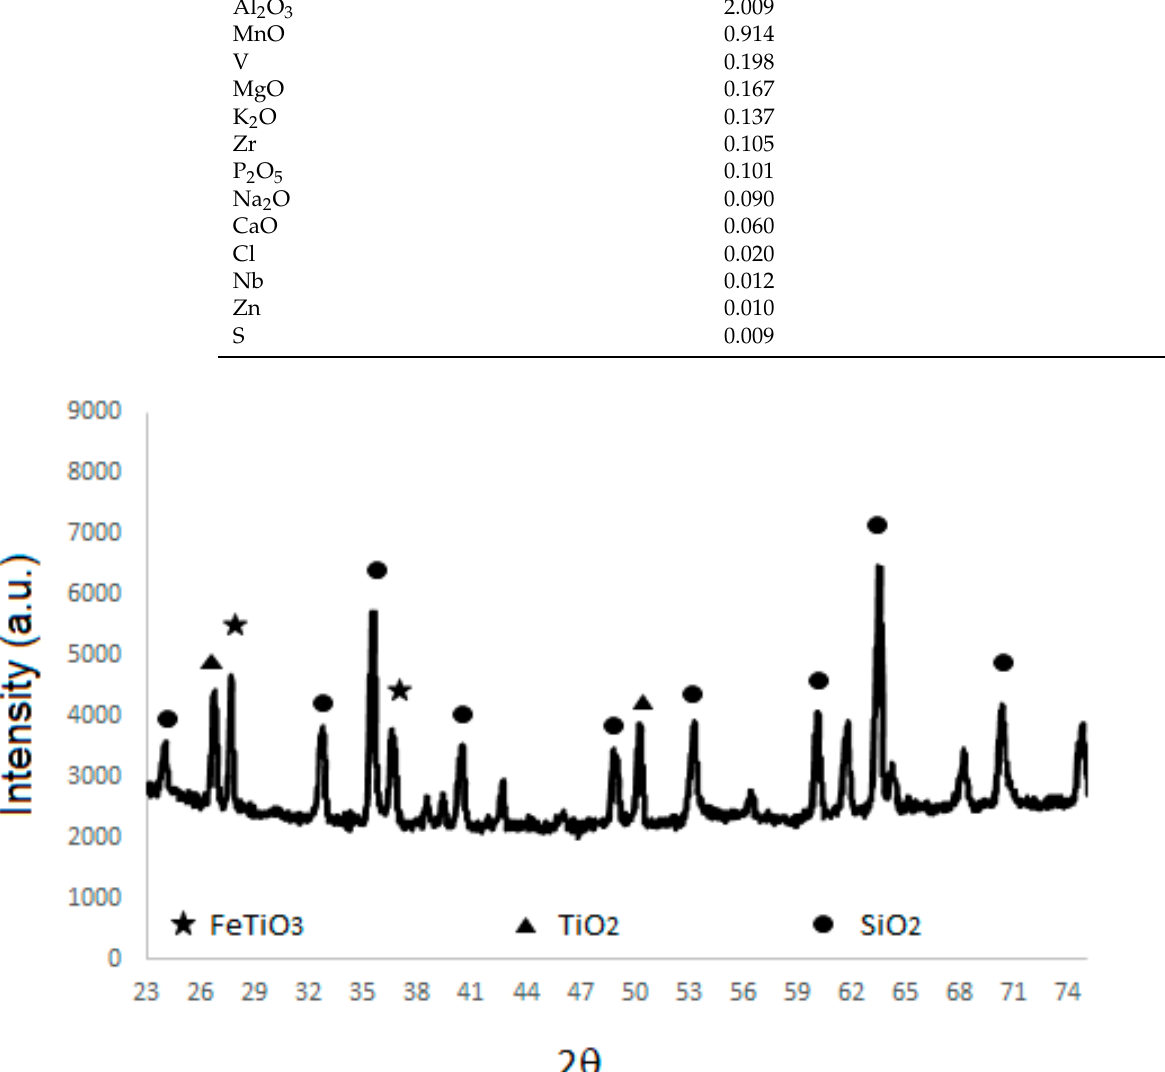
Figure 3. X-ray diffraction pattern of Figure 3. X-ray di ff raction pa tt ern of ilmenite.